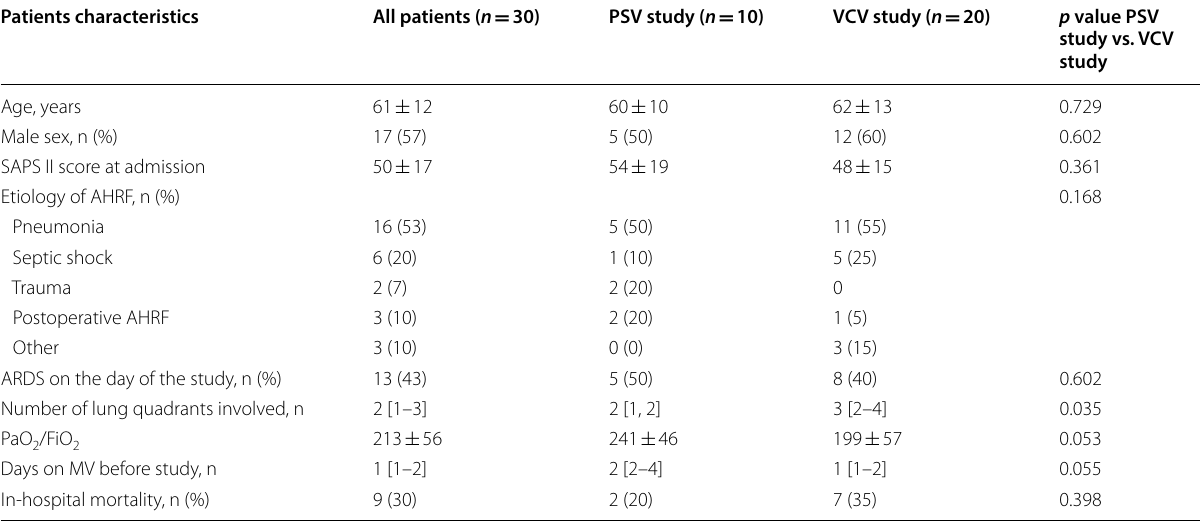
PSV, pressure support ventilation; VCV, volume-controlled ventilation; SAPS, simplified acute physiology score; AHRF, acute hypoxemic respiratory failure; ARDS, adult respiratory distress syndrome; PaO 2 /FiO 2 , oxygen partial arterial tension/inspired oxygen fraction; MV, mechanical ventilation